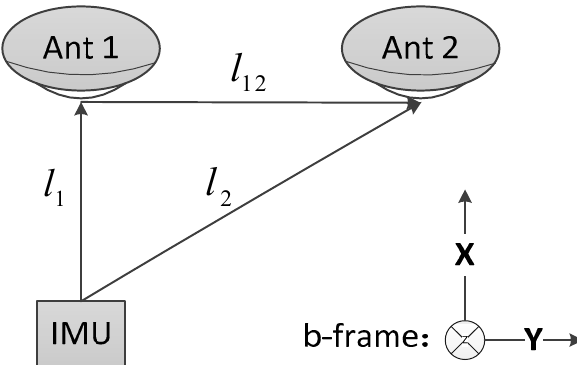
Figure 1. Physical-location relationship between the inertial measurement unit (IMU) and two Global Navigation Satellite System (GNSS) receiver antennas in the body frame.